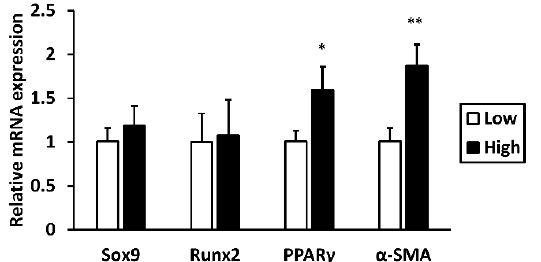
Figure 1. High glucose elevates mRNA expression of PPAR γ and α -SMA . The mRNA expression levels of the non-tenogenic lineage markers Sox9 , Runx2 , PPAR γ , and α -SMA were measured after tenocytes were cultured in high-glucose (25.5 mM) or low-glucose (5.5 mM) conditions for 1 week. Data are presented as the mean ± SD ( n = 6). Statistical significance is shown as * p < 0.05 or ** p < 0.01 compared to the low-glucose control group. Experiments were performed as four biologically independent repeats.